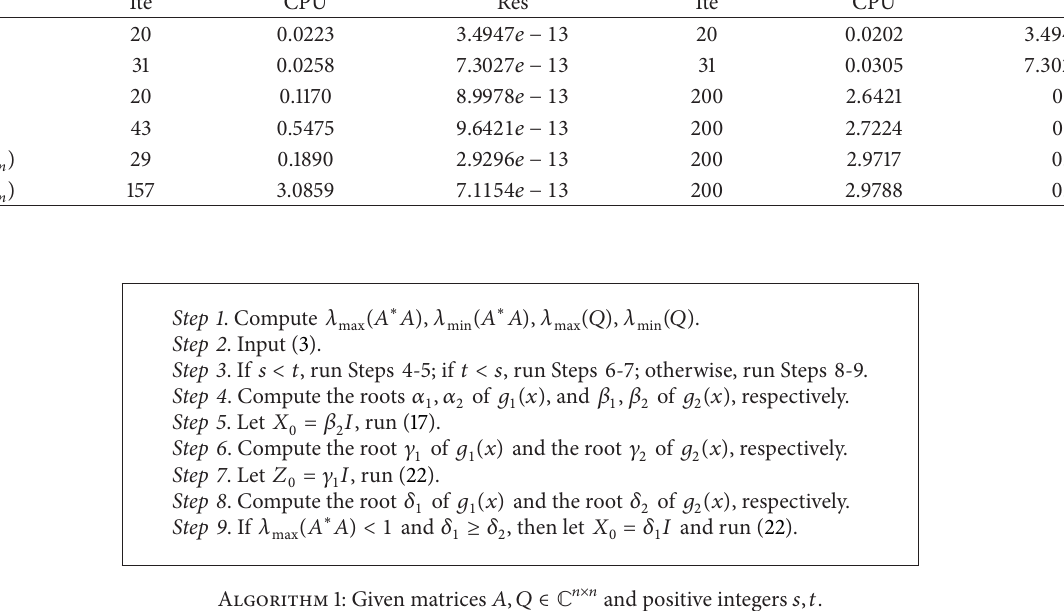
Table 2: Iteration, CPU time (seconds) and residue for solving (1) with 𝑠 = 𝑡 and different initial solutions. (𝑠,𝑡, 𝑋 ) Algorithm 0